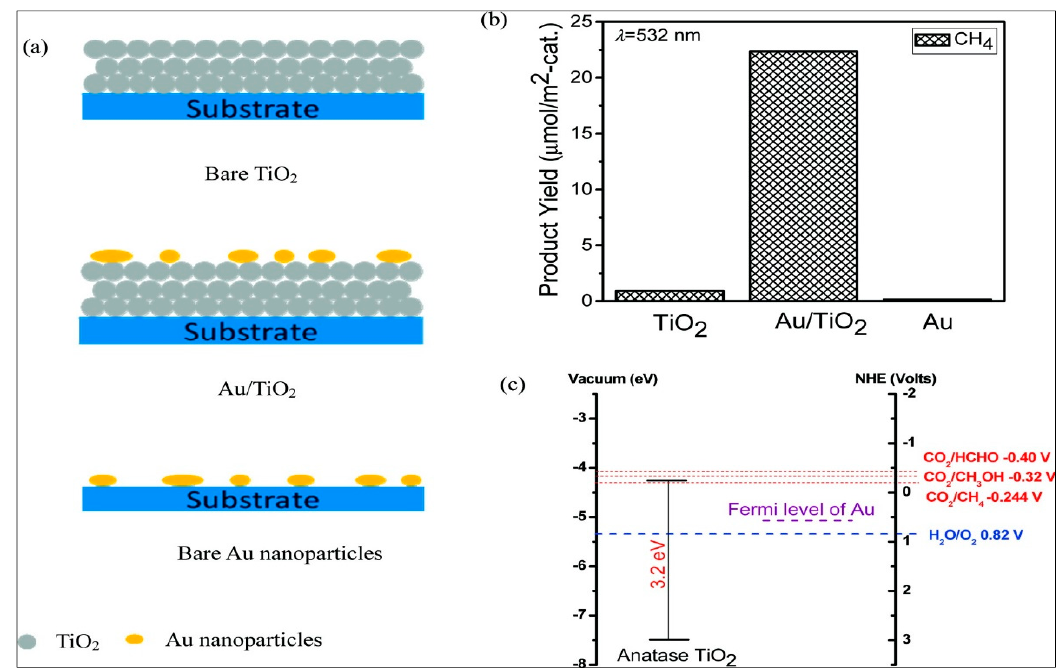
Figure 5. ( a ) Schematic diagrams of bare Au, Au/TiO 2 and the bare TiO 2 photocatalysts, ( b ) amount of CH 4 formed on these photocatalyst surfaces after 15 h and ( c ) the relevant redox potentials of CO 2 and H 2 O under visible light and energy band positions of anatase TiO 2 and Au (Adapted from [155]).